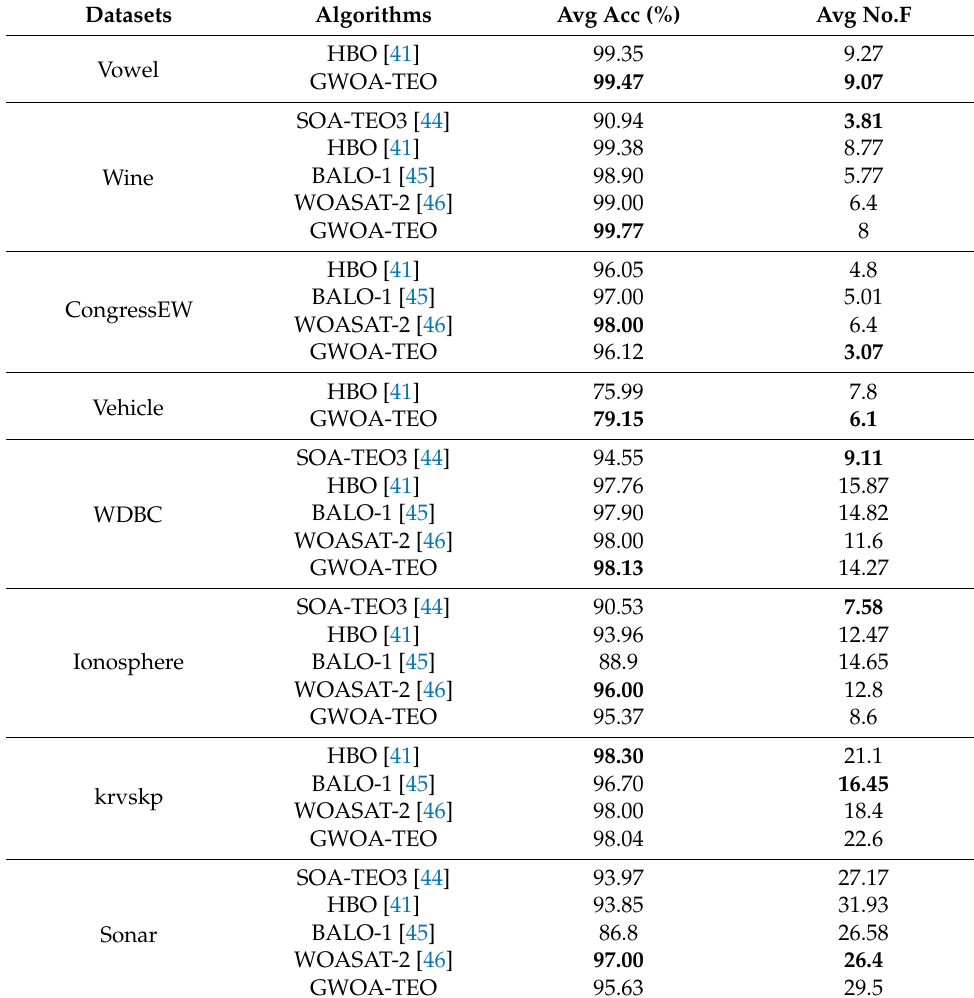
Table 7. Comparison with published feature selection